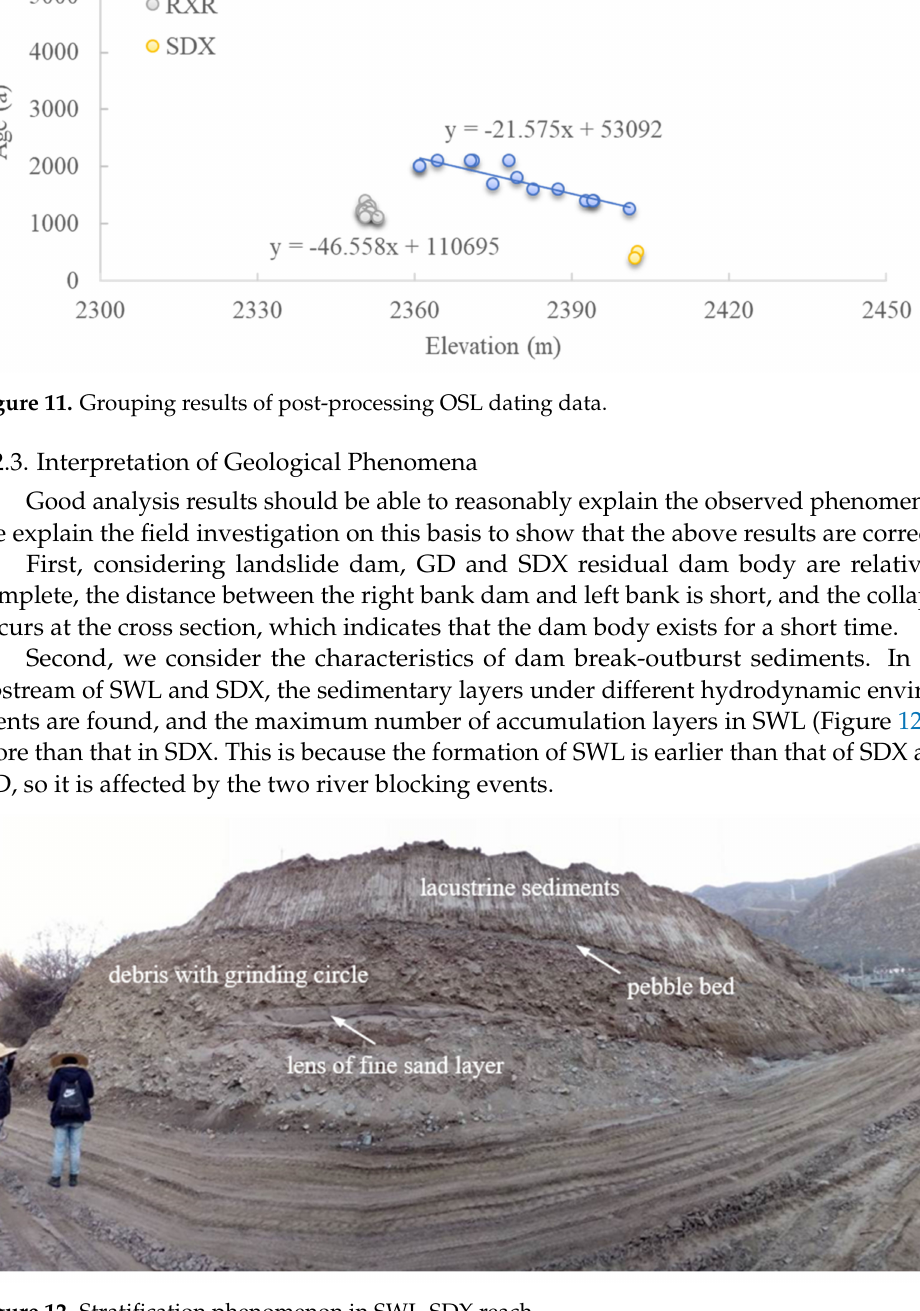
Figure 12. Stratification phenomenon in SWL-SDX